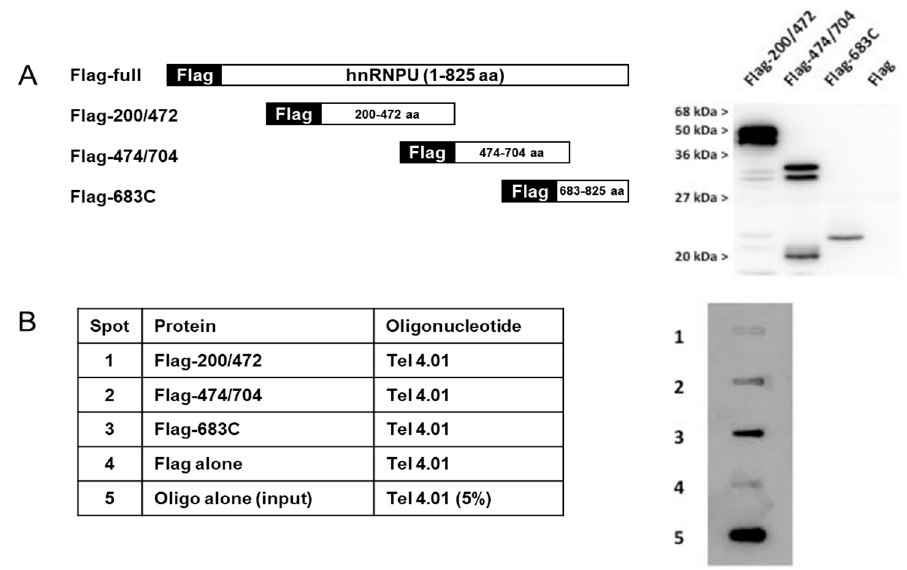
Figure 2. ( A ) Schematic illustration showing three di ff erent constructs of Flag-hnRNP U protein made in E. coli , and each protein was subjected by Western blotting with anti-Flag antibody. ( B ) Each Flag-hnRNP fusion protein was IP:d with anti-Flag agarose gel, and IP were mixed with Tel in KCl bu ff er. Same treatment as in Figure 1A. Oligo alone (input) indicates that the 5% oligo used in the binding assay was spotted directly.